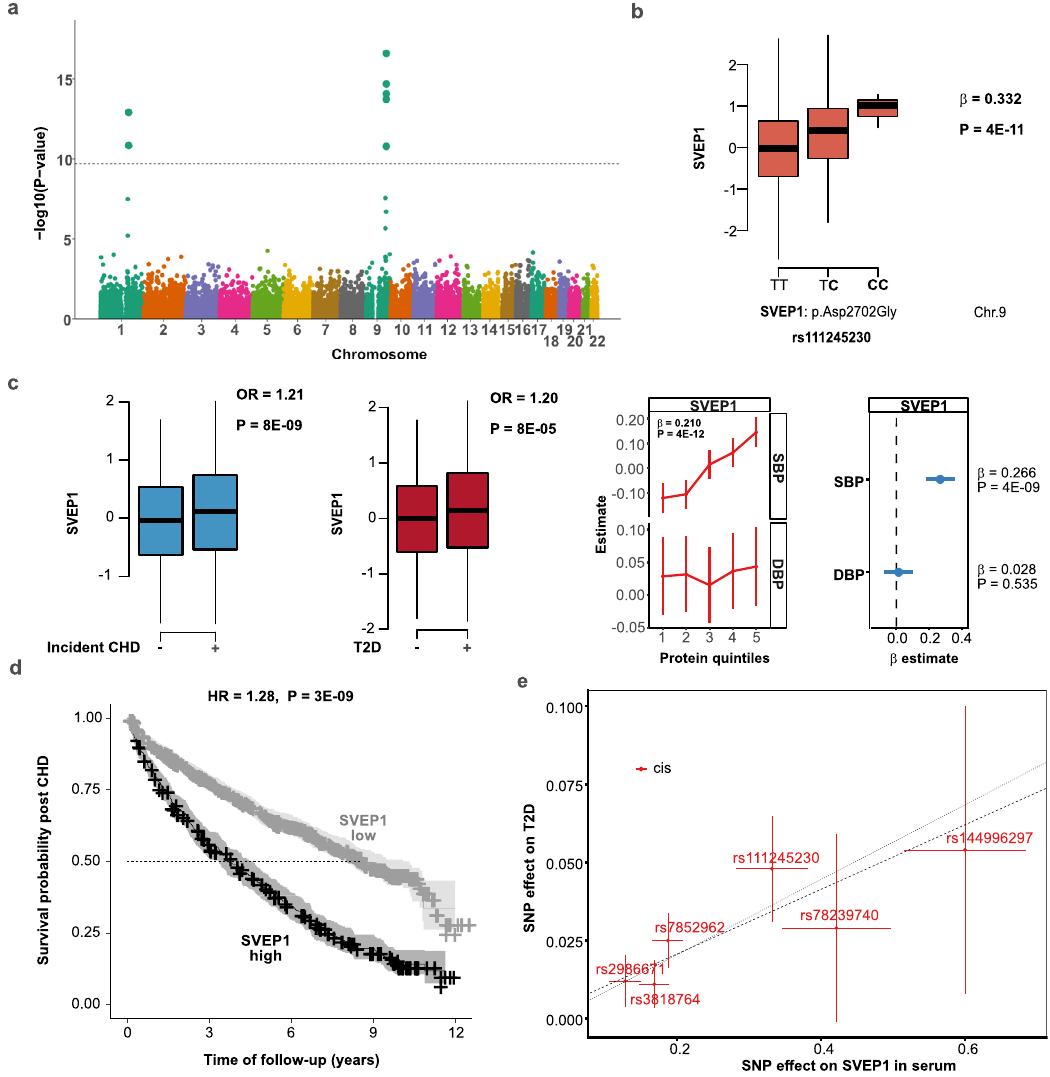
Fig. 5 Variants affecting SVEP1 levels are associated with CHD, blood pressure, and T2D. a The Manhattan plot reveals variants at chromosomes 1 and 9 associated with serum SVEP1 levels. Study-wide signi fi cant associations (linear regression, P < 1.92 × 10 − 10 , two-sided) are indicated by the horizontal line. The y -axis shows the − (log 10 ) of the P -values for the association of each genetic variant on the exome array present along the x -axis. b One of the variants associated with SVEP1 levels and underlying the peak at chromosome 9 is the low-frequency CHD risk variant rs111245230 (NP_699197.3: pD2702G). The CHD risk allele C (highlighted in bold) is associated with increased serum SVEP1 levels. The x -axis of the box plot shows the genotypes for the protein-associated SNP, while the y -axis denotes the Box – Cox transformed, age, and sex-adjusted serum protein levels. The P -value (two-sided) shown at the top of the plot is derived from linear regression analysis. Box plots indicate median (middle line), 25th, 75th percentile (box), and 5th and 95th percentile (whiskers). c Serum levels of SVEP1 were associated with incident CHD ( P = 8 × 10 − 9 ) and T2D ( P = 8 × 10 − 5 ). The P -values (two-sided) at the top of each boxplot for CHD and T2D come from logistic regression. The comparison of protein quintiles of the SVEP1 levels in serum with systolic (SBP) or diastolic (DBP) show a signi fi cant positive correlation with SBP ( β = 0.210, P = 4 × 10 − 12 , two-sided) but not with DBP ( P > 0.05, two-sided). The relationship between the top and bottom quintiles of serum SVEP1 levels and blood pressure is depicted in the right-most panel. The x -axis of the box plots shows the health status of individuals, while the y -axis denotes the Box – Cox transformed, age, and sex-adjusted serum protein levels. Box plots indicate median (middle line), 25th, 75th percentile (box), and 5th and 95th percentile (whiskers). d Consistent with the directionality of the effects described above, we fi nd that elevated levels of SVEP1 were associated with higher rates of mortality post-incident CHD. The Kaplan – Meier plot calculates the hazard ratio (HR) by comparing the 75th and 25th percentiles of SVEP1 serum levels. The vertical ticks correspond to individuals lost to follow-up while the shaded areas indicated the 95% con fi dence intervals. The P -value (two-sided) and HR are shown at the top of the plot. e Scatterplot for the SVEP1 protein supported as having a causal effect on T2D in a two-sample MR analysis. The fi gure demonstrates the SNP effect on serum SVEP1 levels ( x -axis) and T2D from a GWAS in Europeans 35 ( y -axis), with 74,124 T2D patients and 824,006 controls. Each center data point displays the estimated effect as beta coef fi cient = log(odds ratio), along with 95% con fi dence intervals for the SNP effect on disease (vertical lines) or SNP effect on the protein (horizontal lines). The broken line indicates the inverse variance weighted causal estimate ( β = 0.104, SE = 0.023, P = 5.7 × 10 − 6 , two-sided), while the dotted line demonstrates the MR – Egger regression (see Supplementary Data